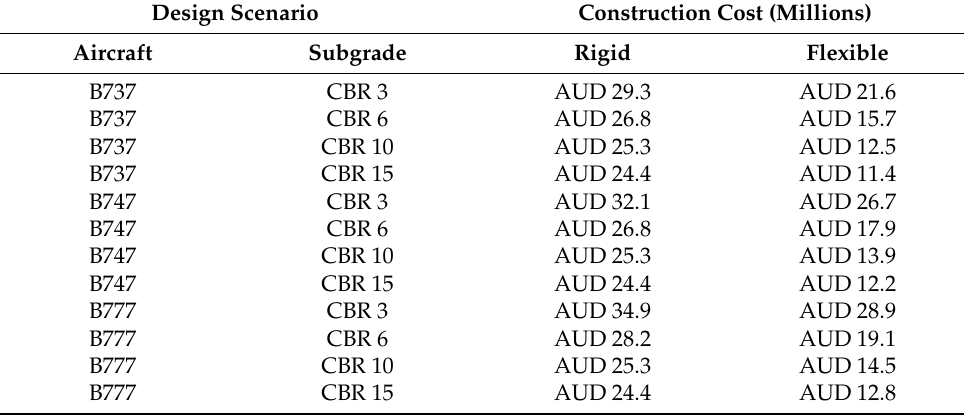
Table 6. Estimated construction costs.